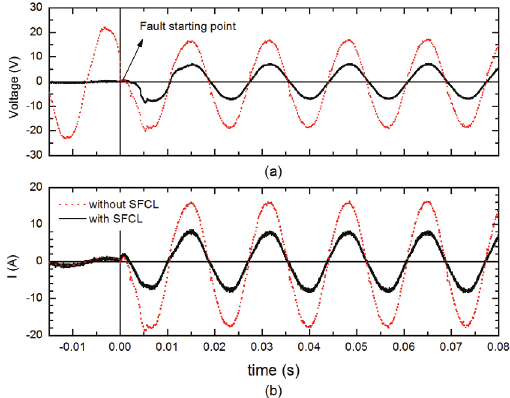
Figure 3. Second ac test of the device for fault duration time of five cycles. This test was done with Hg,Re-1223 sample. The resistances were R = 20.0 Ω and R = 1.0 Ω . 1 2